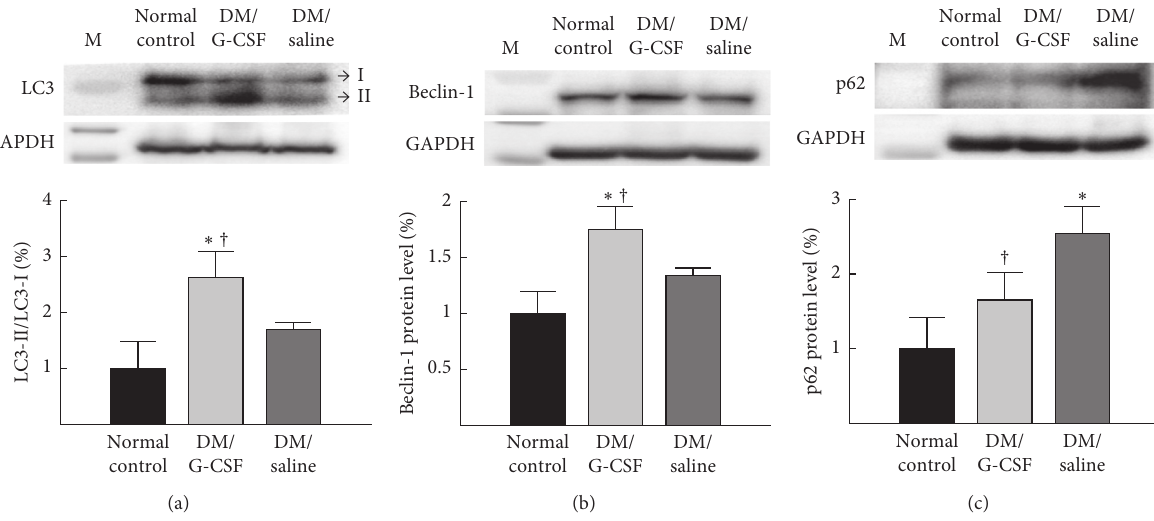
Figure 4: Expression of proteins related to autophagy in the liver. The levels of microtubule-associated protein light chain 3 (LC3) (a), beclin-1 (b), and p62 (c) proteins in the liver tissues were measured by Western blotting. The representative images of the Western blotting analyses are displayed on the upper panels, and quantitative densitometry analysis is shown in the lower panels. LC3 expression was normalized by calculating LC3 conversion as the ratio of LC3-II/LC3-I expression. Beclin-1 and p62 expression levels were normalized by comparison with the levels of glyceraldehyde-3-phosphate dehydrogenase (GAPDH). M, marker and DM, diabetes mellitus. All data are expressed as the means ± standard deviations ( n � 8 per group). ∗ P < 0 . 05 vs. normal control. † P < 0 . 05 vs. DM/saline.